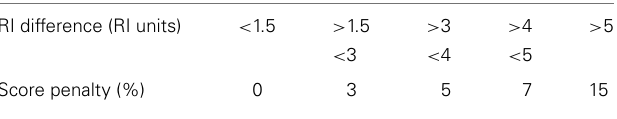
Table 1 | Similarity score penalties based on RI difference of peaks to database entries